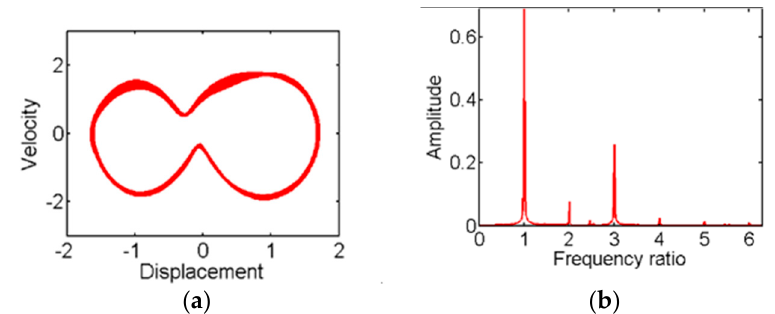
Figure 10. Dynamic behavior of system with misalignment fault. ( a ) Spectrum diagram; ( b ) Phase Diagram.